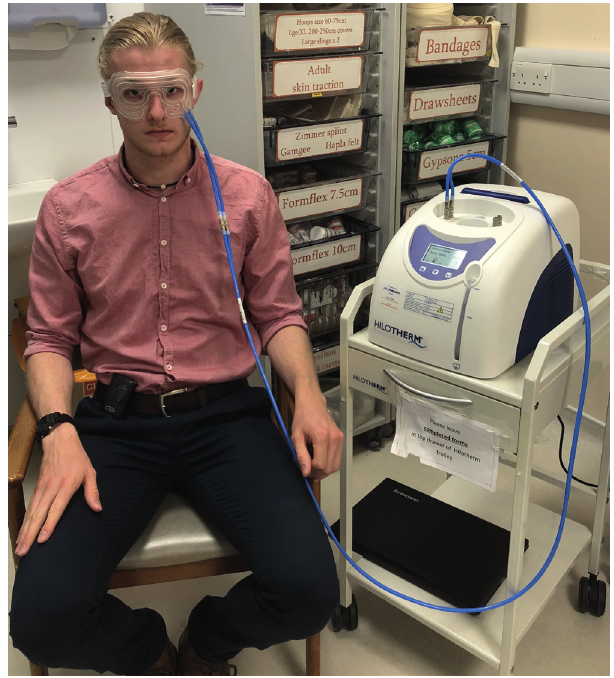
Figure 1. Hilotherm mask